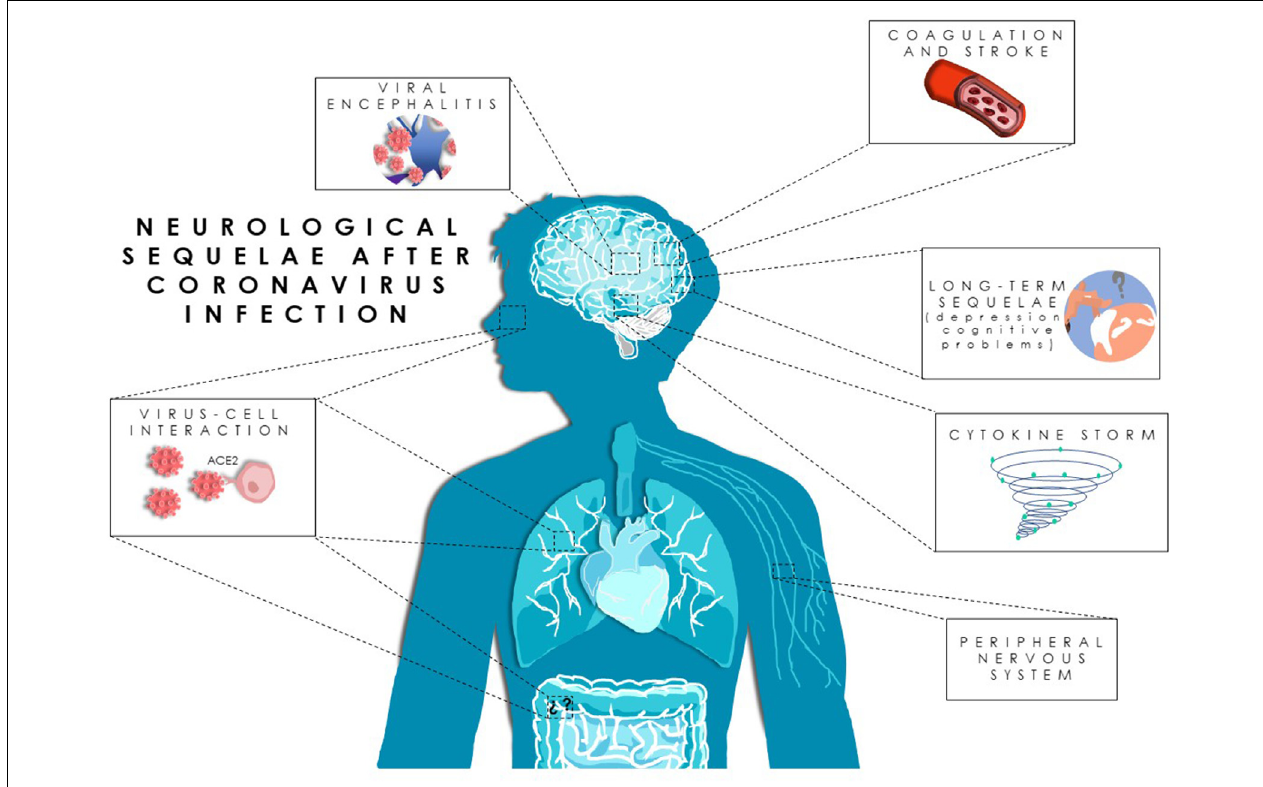
FIGURE 1 | Neurological sequelae after severe acute respiratory syndrome coronavirus 2 (SARS-CoV-2) infection. Proposed pathways for SARS-CoV-2 neuroinvasion and neurological manifestations in coronavirus disease 2019 (COVID-19) patients.